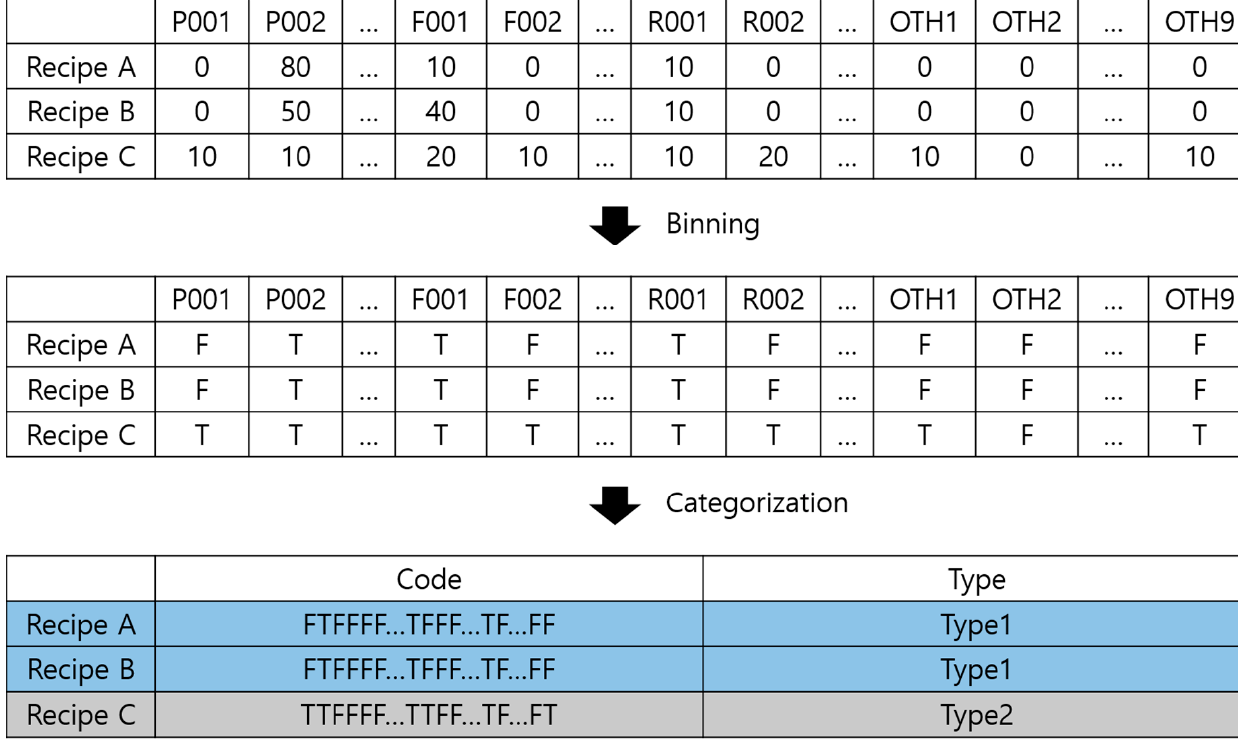
Figure 11. Process of composite categorization based on the presence or absence of materials. Table 2. Amount of data for the studied physical